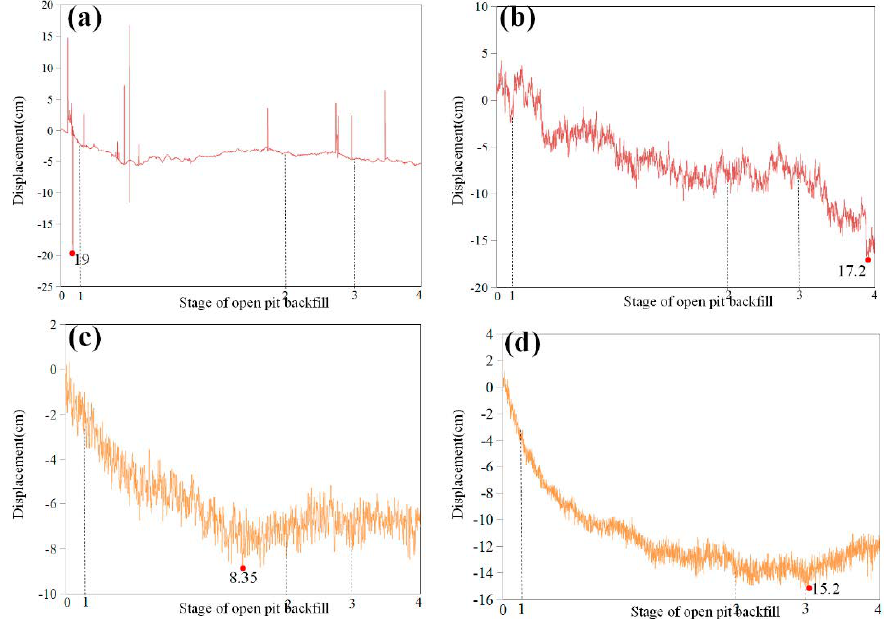
Figure 12. Displacements of measuring point 1 ( a ) vertical, ( b ) horizontal, and 2 ( c ) vertical, ( d ) hor- izontal.